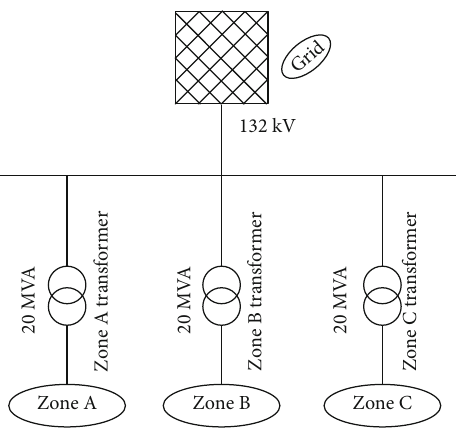
Figure 11: Simulation diagram of a 132kV grid after DG